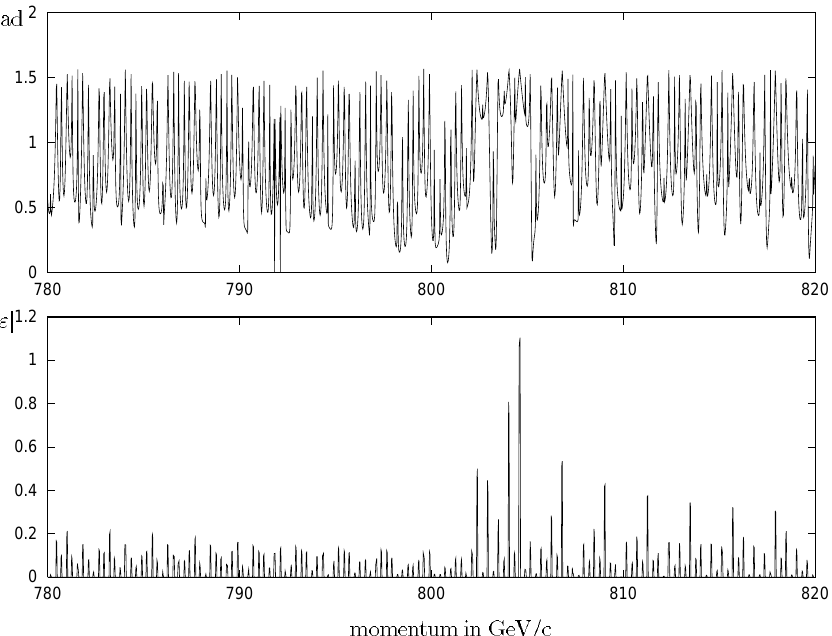
FIG. 3. SLIM opening angles of (cid:2) n (cid:2) (cid:2) z (cid:3) (top) and resonance strength (bottom) for a beam with normalized vector emittance of 4 p mmmrad in